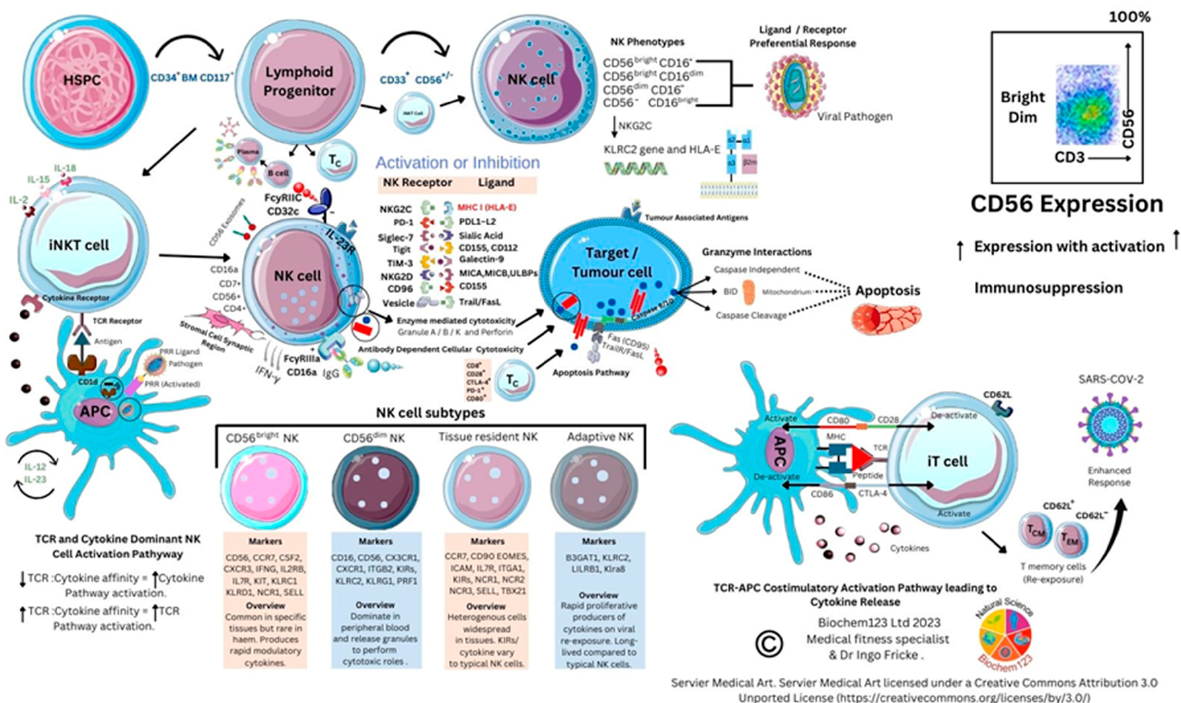
Figure 10. Natural killer cell phenotype diversity and maturation.